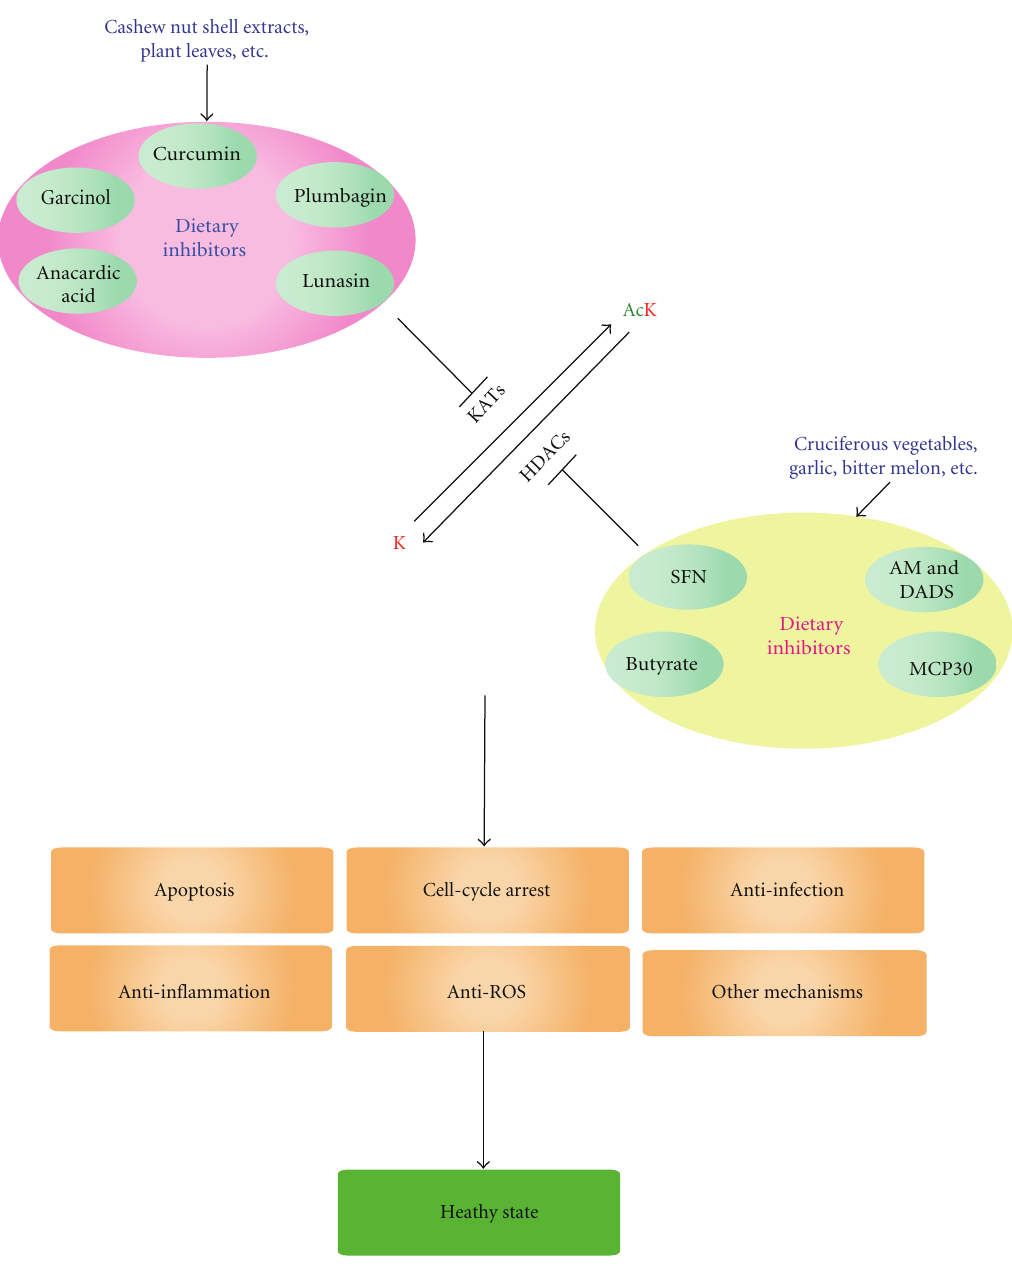
Figure 2: Diagram showing e ff ects of dietary KAT and HDAC inhibition. The capital letter K (in red) refers to a lysine residue and Ac in green refers to acetylation. Di ff erent dietary components act on distinct KATs and HDACs to produce di ff erential cellular e ff ects depending on cell types and conditions. On the KAT and HDAC modulators illustrated here, all are small molecules except lunasin and MCP30, which are a 43-residue polypeptide and a 30kDa protein, respectively. In addition to the inhibitors illustrated here, KAT and HDAC activators, as well as dietary patterns (such as high fat diet, high salt ingestion, and calorie restriction) and environmental factors, may target the acetylation